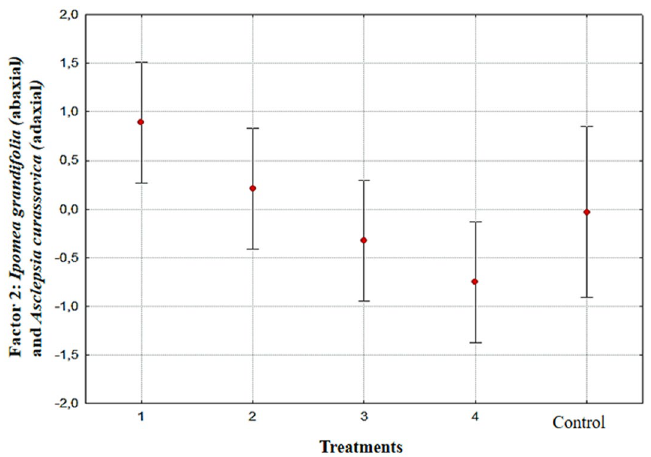
Figure 2. Graphical representation with Factor 2 ( Ipomoea grandifolia (abaxial) and Asclepias curassavica (adaxial) scores) as a function of the evaluated samples. Vertical bars represent confidence intervals of 0.95 (F = 4.036, p = 0.009). Spray solution: 1-No adjuvant; 2-herbicide associated with vegetable oil; 3-herbicide associated with mineral oil; 4-herbicide associated with lecithin, and